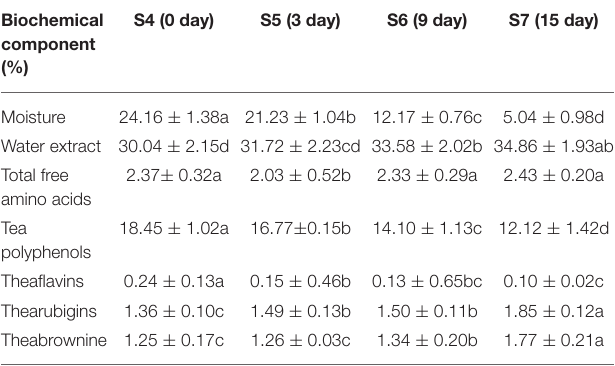
TABLE 3 | Analysis of biochemical components of Ganpu tea samples with different durations of the full sun-drying processing. Biochemical component